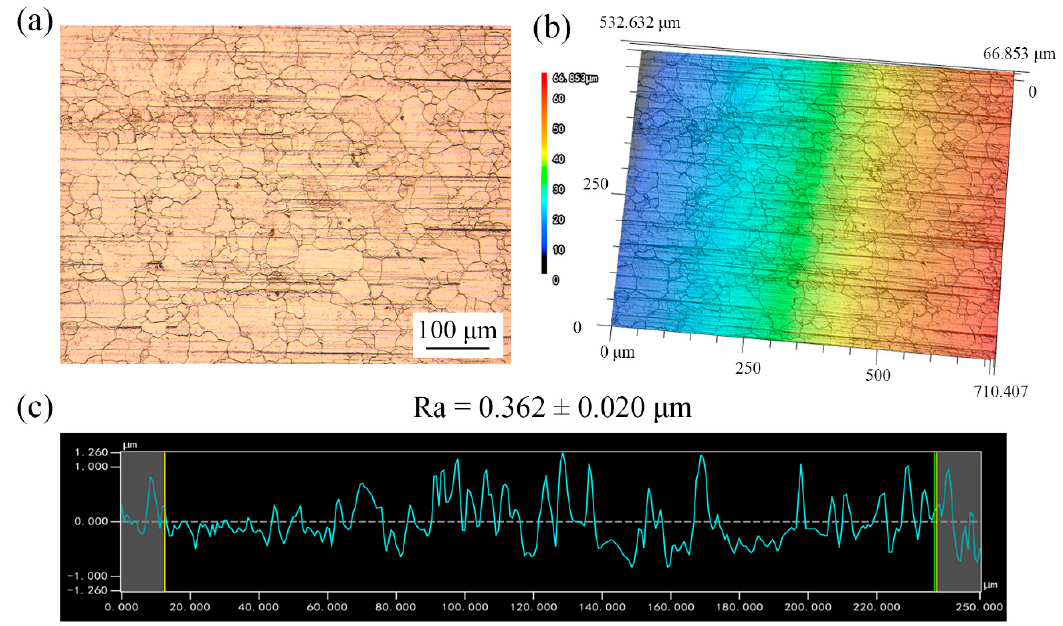
Figure 6. Surface topography of copper foils annealed at 650 °C with LPS. ( a ) 2D surface topography; ( b ) 3D surface topography; ( c ) roughness curve.